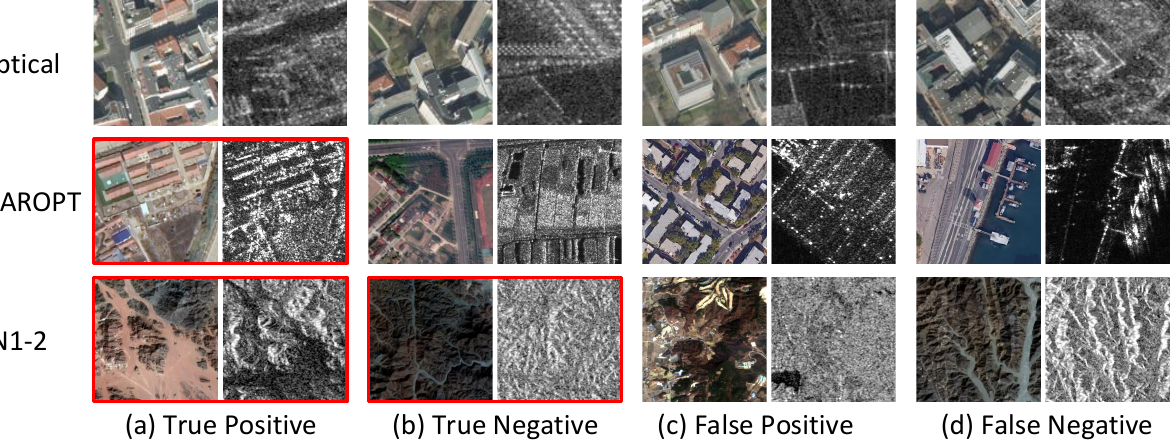
Figure 6. Exhibition of images pairs in different matching results. The red boxes frame the image pairs that MoCo-BNN classifies correctly and IP-BNN classifies